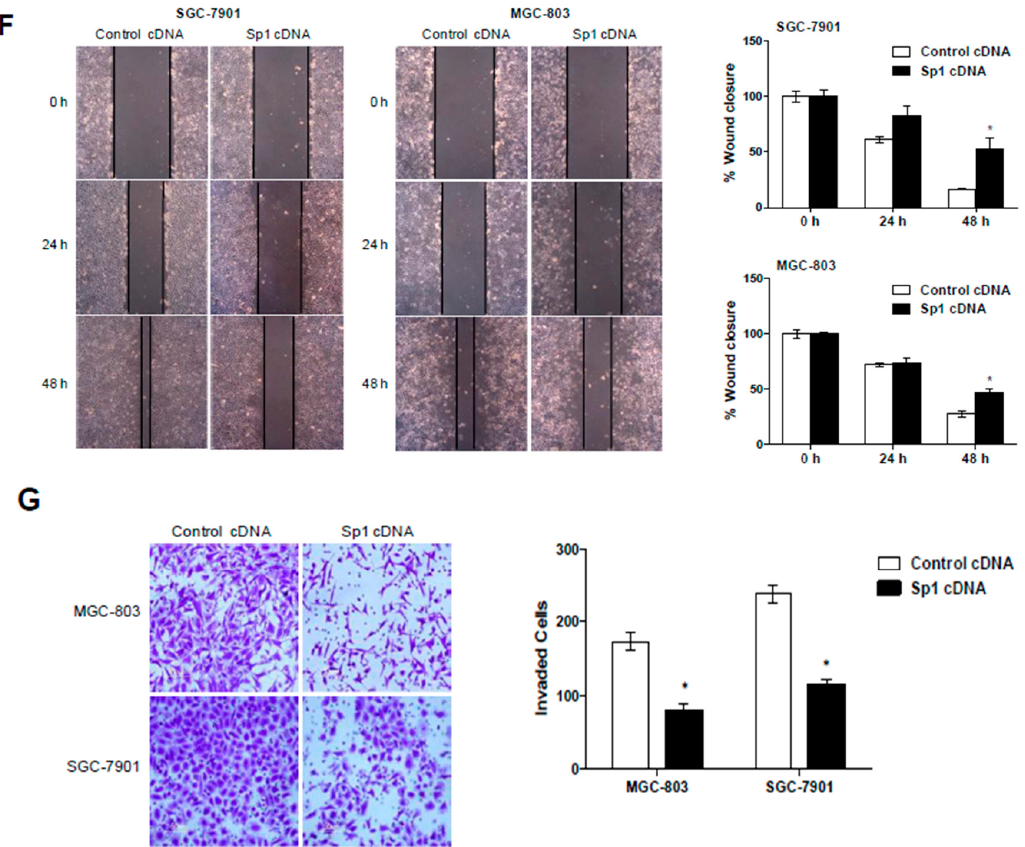
Figure 3. Overexpression of Sp1 inhibits malignant behavior of GC cells. SGC-7901 and MGC-803 cells were transfected with empty vector or an Sp1 construct. Data shown are representative of 3 individual experiments. ( A ) Western blot analysis of whole cell lysates; ( B ) colony formation assays of the cell growth level; ( C ) the percentage of apoptotic cells 48 h after transient transfection by measurement of sub-G1 DNA content ( n = 3, mean ± SEM, * p < 0.01 vs. empty vector); ( D ) Western blot analysis of whole cell lysates for apoptosis-related proteins; ( E ) cell proliferation 72 h after transient transfection by MTS assay ( n = 3, mean ± SEM, * p < 0.05 vs. empty vector); ( F ) cell migration 24 and 48 h after transient transfection by wound healing assays. Right panel shows quantitation of wound closure as shown in the left panel. The y axis represents the percentages of wound closure at 24 or 48 h after wound introduction determined using NIH Image J ( n = 3, mean ± SEM, * p < 0.05 vs. transfection with empty vector for 48 h); ( G ) cell invasion 48 h after transient